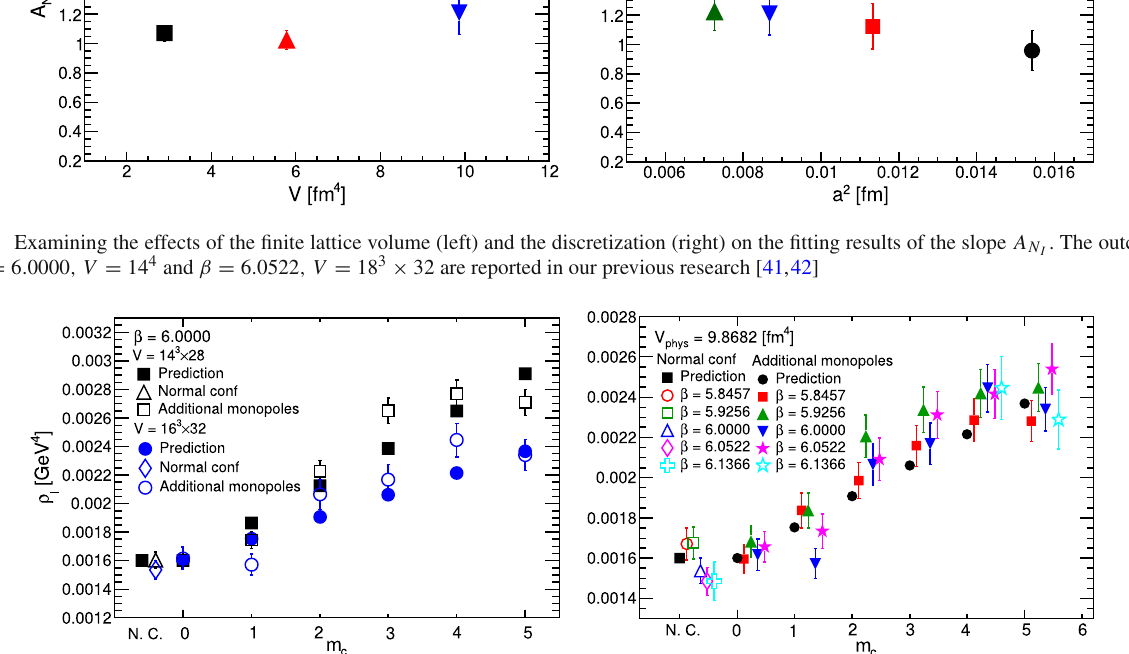
Fig. 8 Comparing the calculated results of the number density of the instantons and anti-instantons ρ I using the configurations of the addi- tional monopoles and anti-monopoles with the predictions. The left panelshowstheresultsofthelatticevolumes V = 14 3 × 28and16 3 × 32,